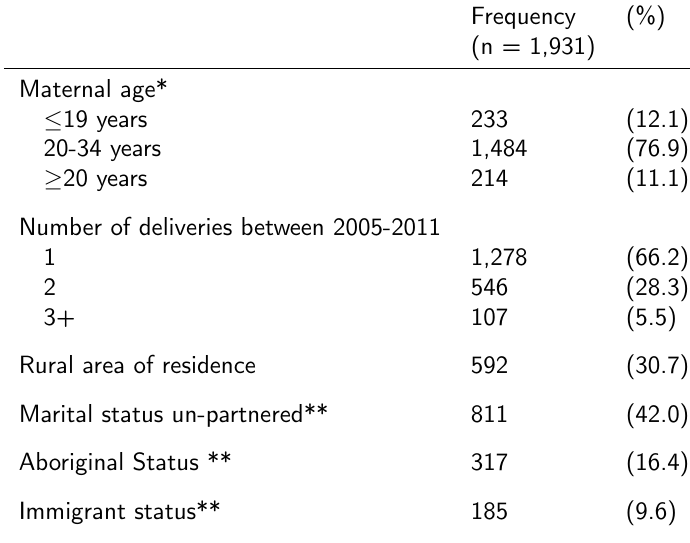
Supplementary Table 3: Maternal characteristics of income